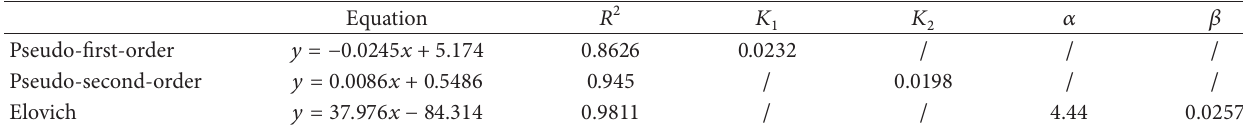
Table 3: Parameter values of the kinetic studies of the adsorption of methylene blue onto activated carbon from cola nut shells.